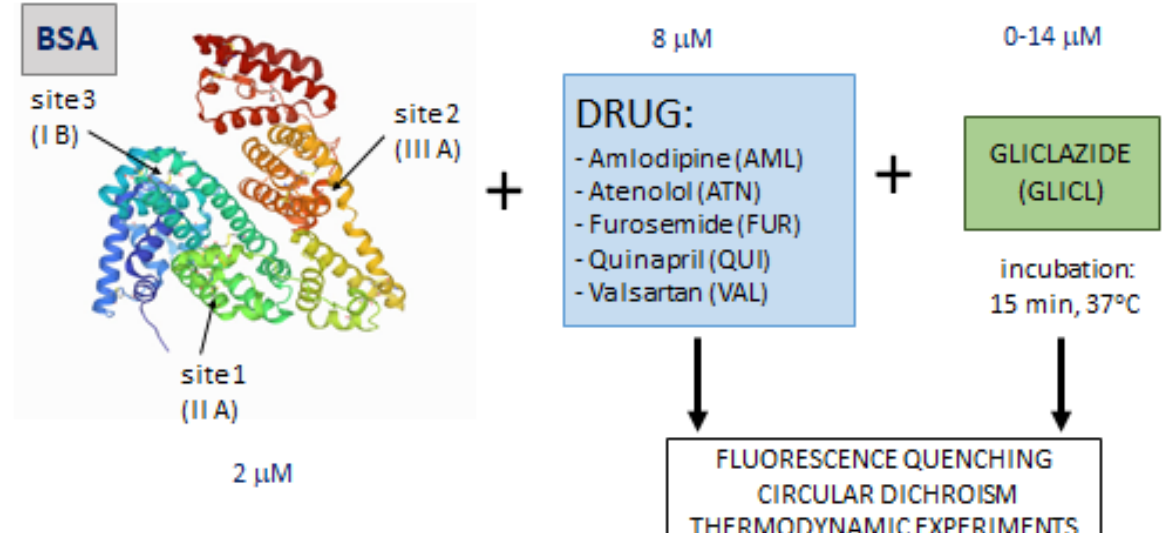
Figure 5. Schematic workflow of the study of binding interactions of the albumin–drug–gliclazide system [47].